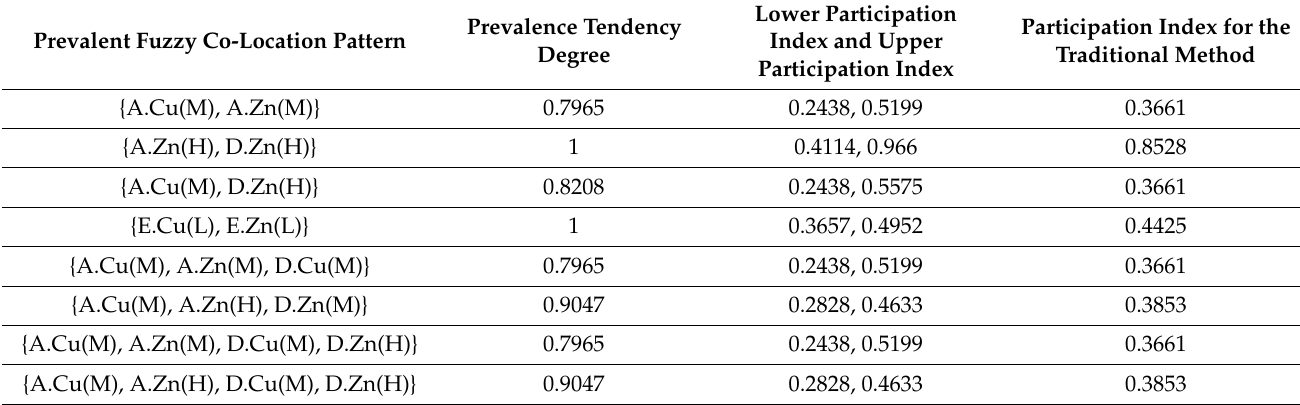
Table 7. Part of the mining results for real dataset